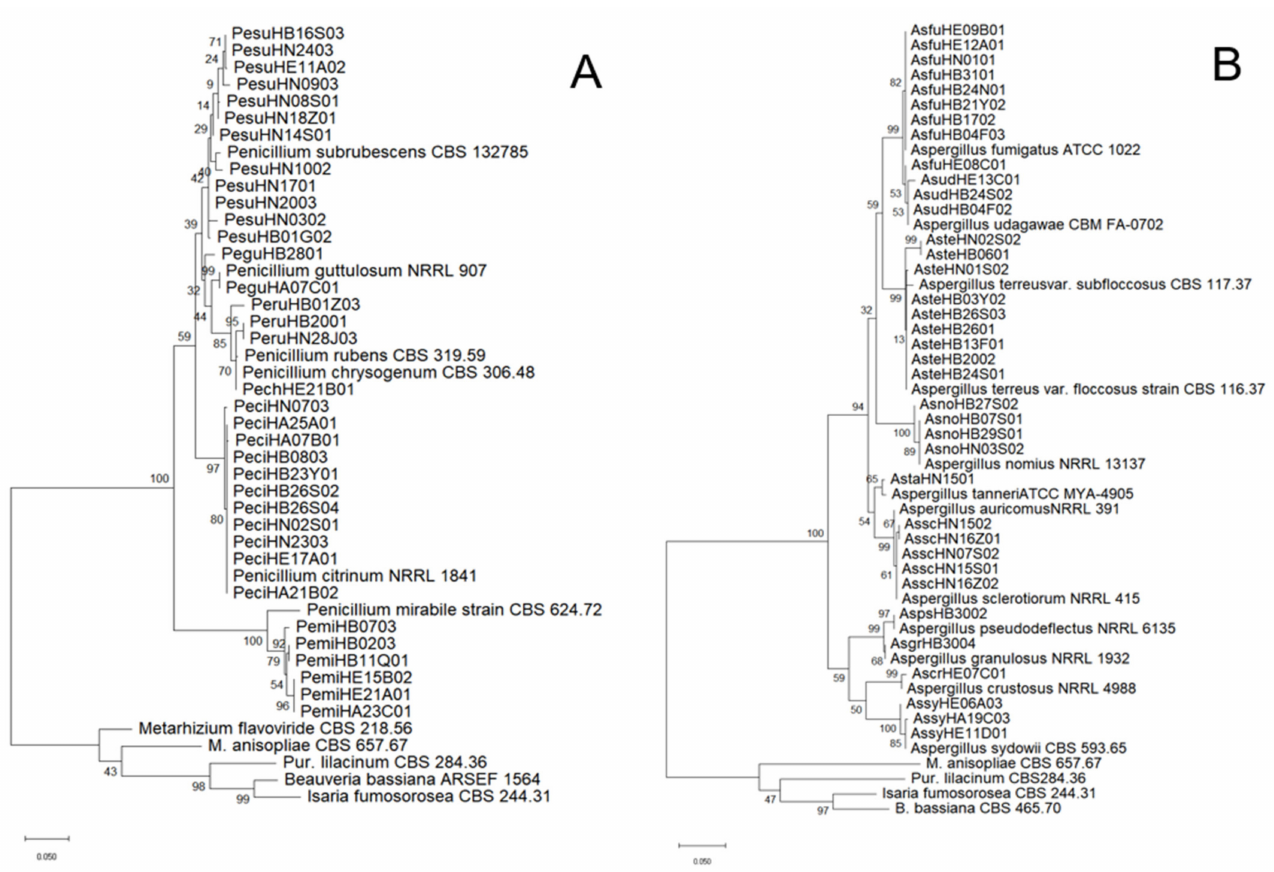
Figure 2. Phylogenetic tree of Penicillium spp. ( A ) and Aspergillus spp. ( B ) isolates.